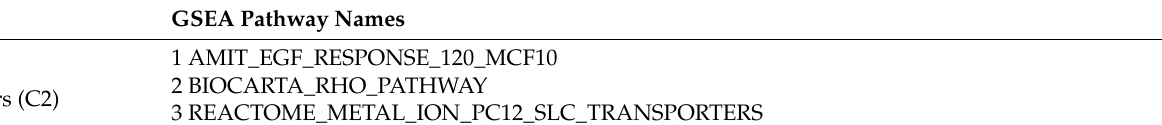
Table 1. List of enriched pathways ( p < 0.01) identified by GSEA from non-responder and responder pre-treatment tumour